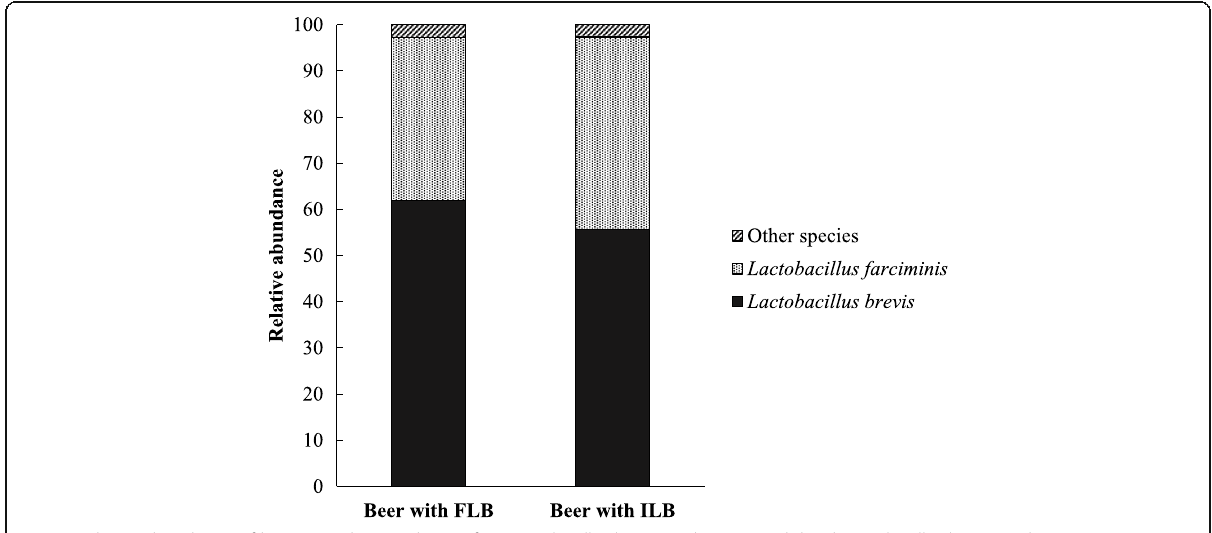
Fig. 8 Relative abundance of bacteria in beer with FLB (free Lactobacillus brevis ) and ILB (immobilized Lactobacillus brevis ) at the species taxonomic level.